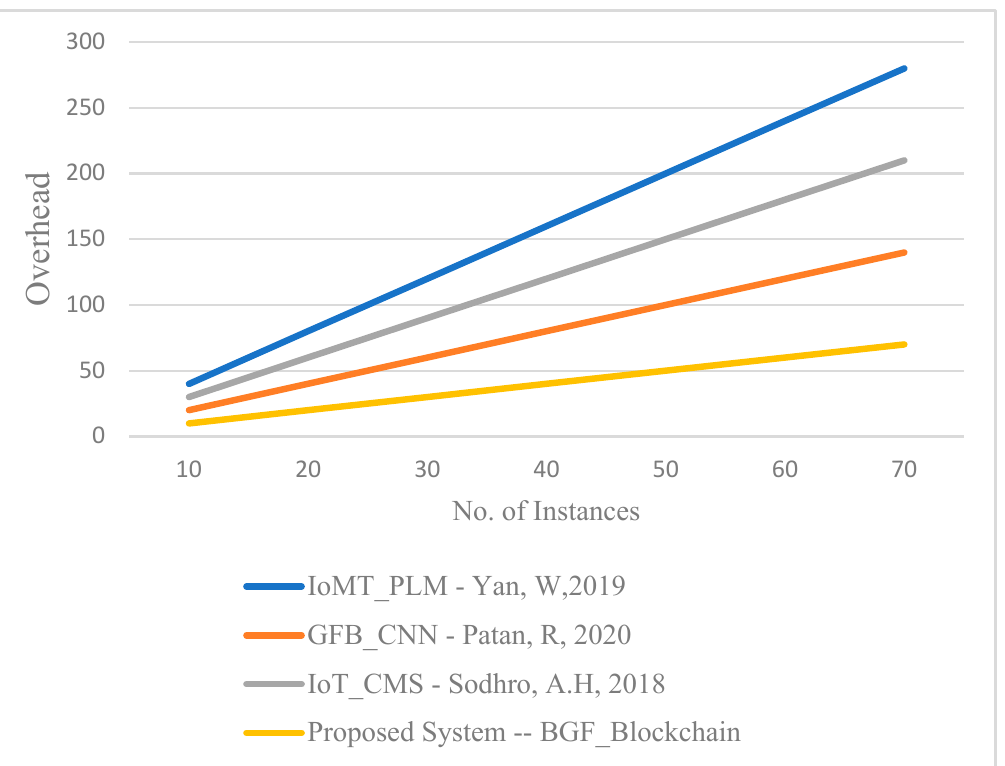
Figure 4. Visualization of Comparison of overhead with the existing systems [1,2,34]. Table 4. Parameters of GWO-PSO Hybrid model.